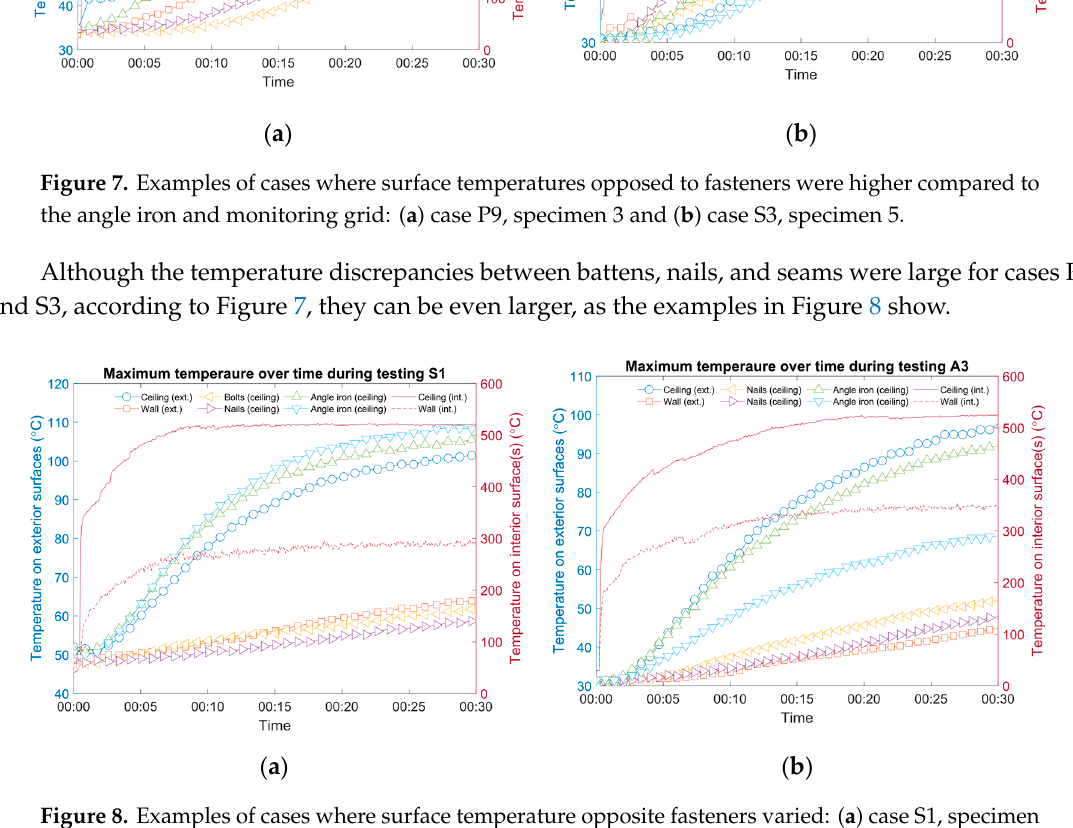
Figure 8. Examples of cases where surface temperature opposite fasteners varied: ( a ) case S1, specimen 4 and ( b ) case A3, specimen 7.